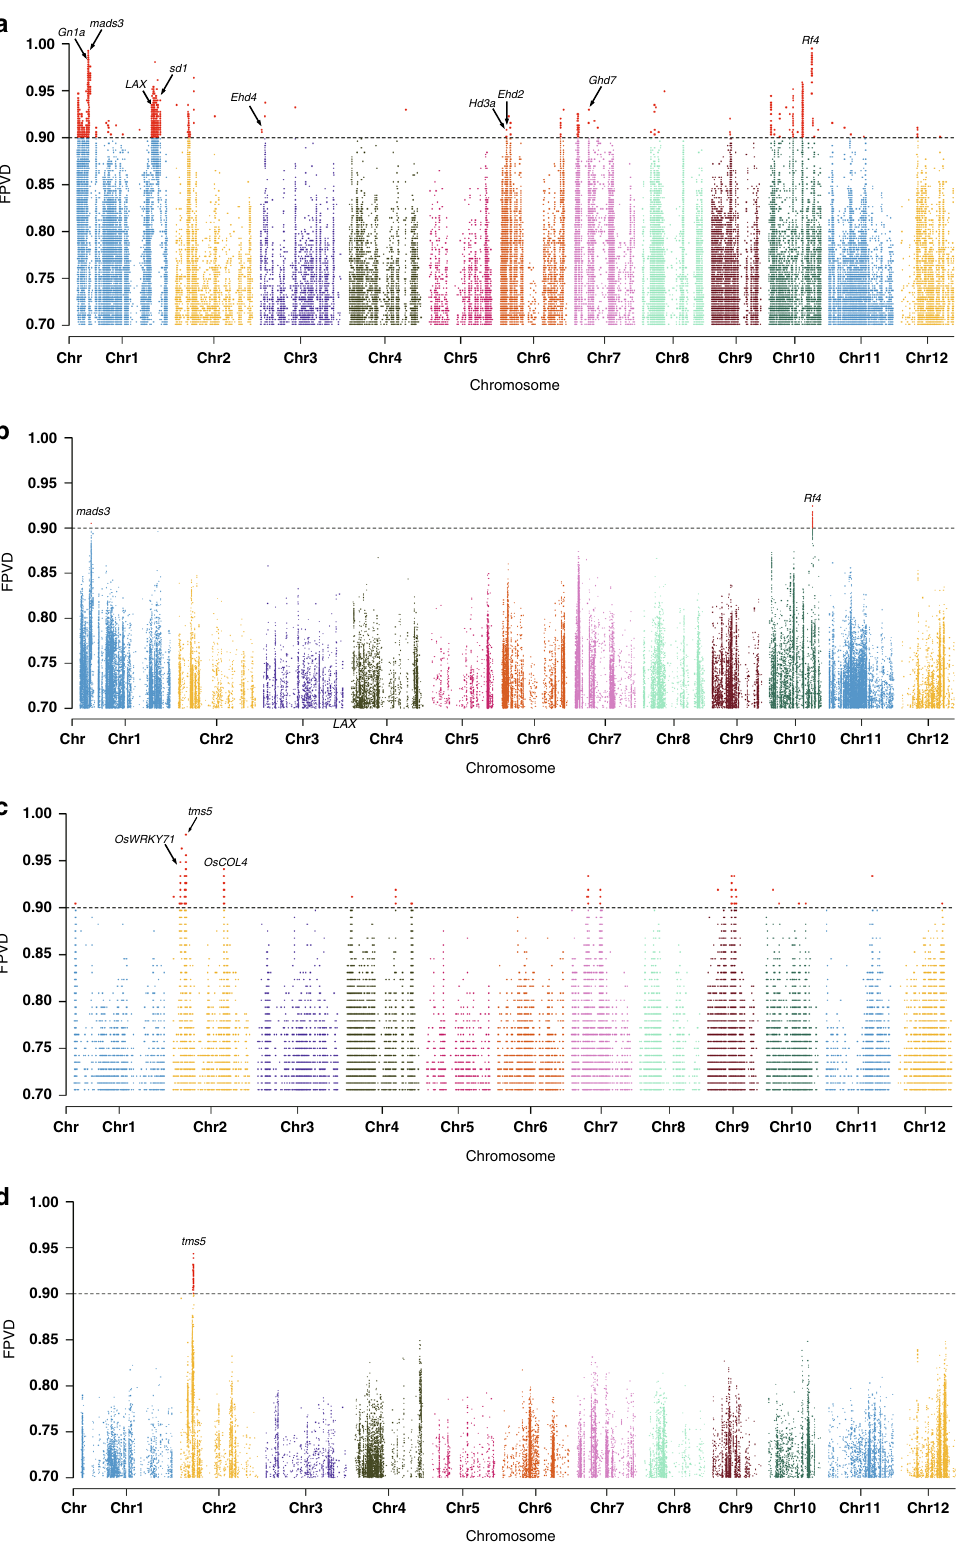
Fig. 3 Genome-wide SNP FPVD analyses. a Superior 3-line hybrids ( n = 415). b Simulated inferior 3-line hybrids ( n = 61,619). c Superior 2-line hybrids ( n = 136). d Simulated inferior 2-line hybrids ( n = 51,114). The inferior 3-line hybrids are the results of simulated crosses between 294 3R and 211 CMS accessions for the 3-line system, with the real superior 3-line hybrids excluded. The inferior 2-line hybrids are the results of simulated crosses between 275 3R + 2R restorers and 110 GMSs, with the real superior 2-line hybrids excluded. Some agronomically important genes located in the loci that we identi fi ed are labeled. Source data are provided as a Source Data fi